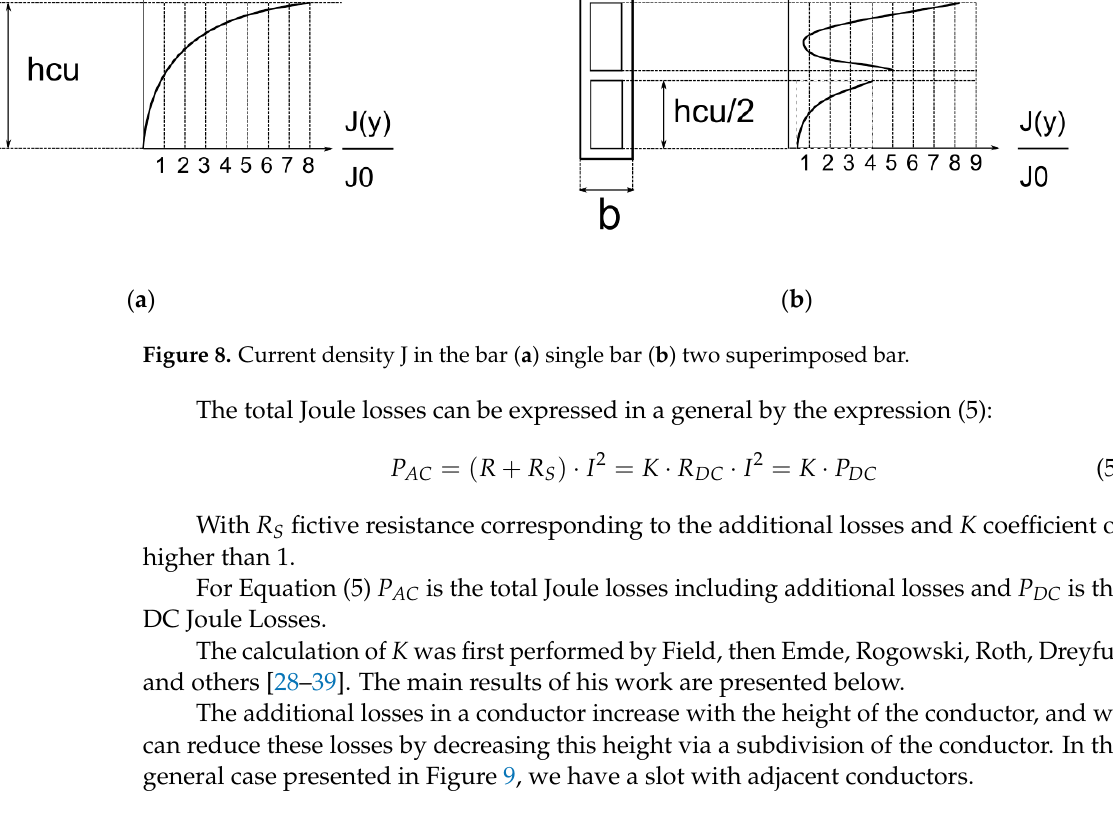
Figure 7. H fields in the bar.